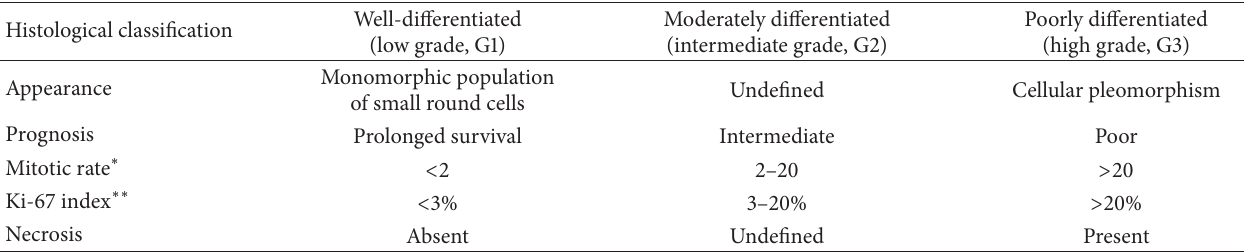
Table 1: Histopathological classification of neuroendocrine tumors.